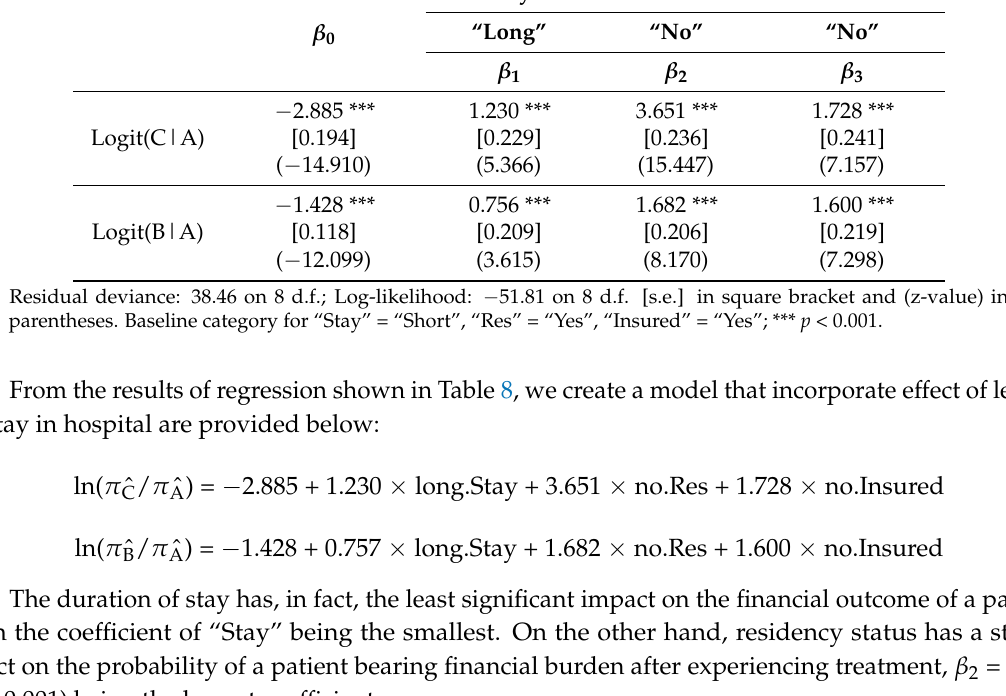
Table 8. Estimation of parameters for modelling on hospital stay. “Stay” “Res” “Insured” “Long” β 0